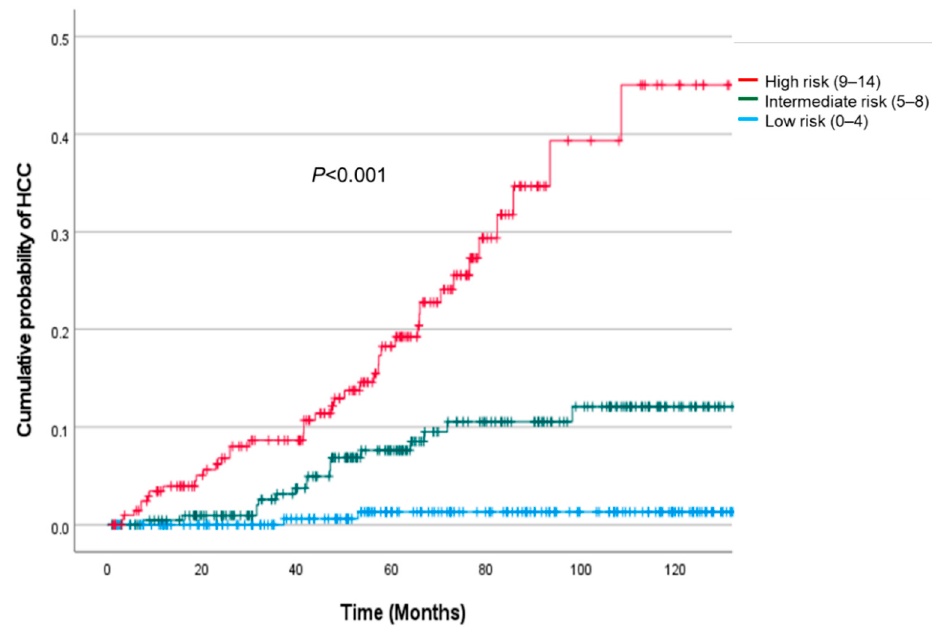
Figure 2. Cumulative incidence of hepatocellular carcinoma in the high-risk, intermediate-risk, and low-risk groups.